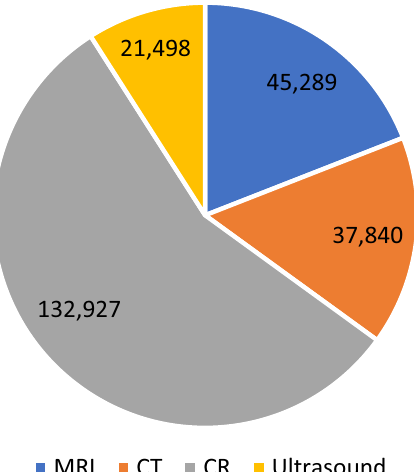
Fig. 2 Imaging per modality. Distribution of imaging used per